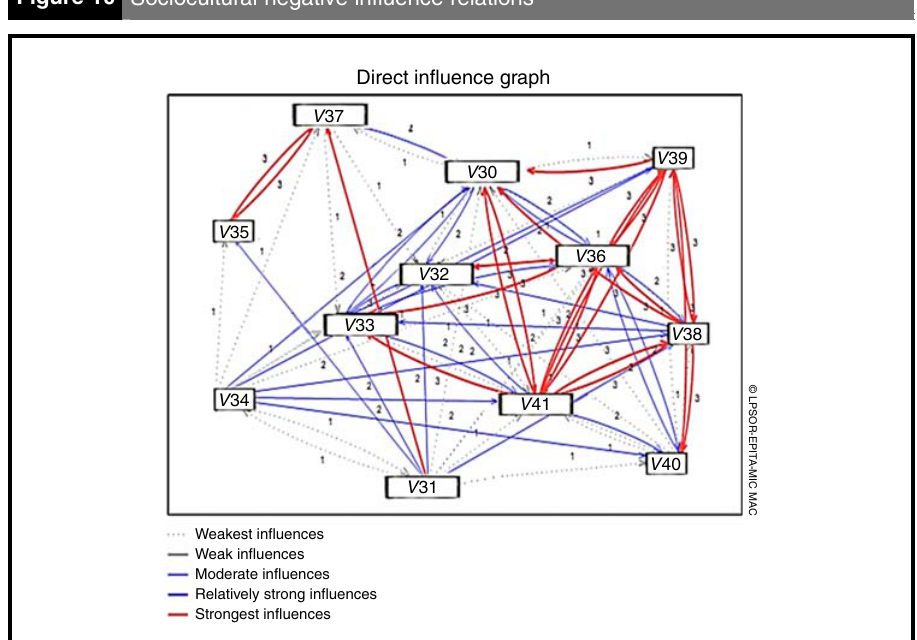
Figure 10 Sociocultural negative influence relations Direct influence